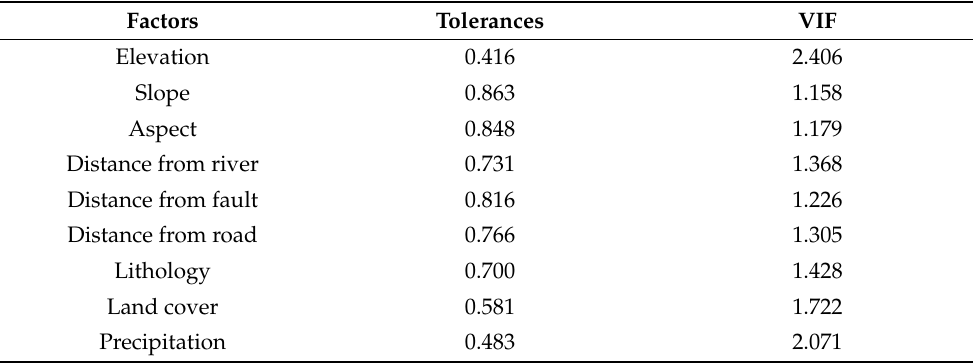
Table 6. Covariance test results of the landslide